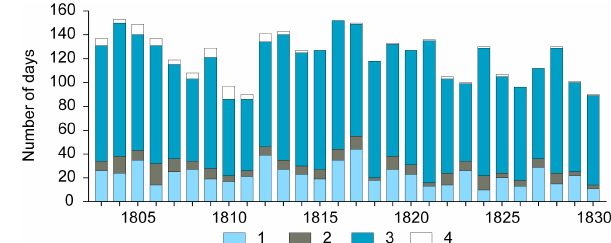
Figure 6. Fluctuations in the annual number of precipitation days (1 – solid, 2 – mixed, 3 – liquid) at Buchlovice during 1803–1830 derived from the weather diary kept by Šimon Hausner (4 – missing